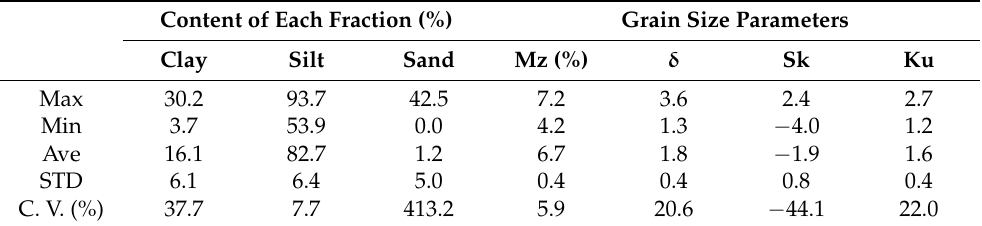
Figure 5. Grainsize classification. The mean grain size (Mz) of samples varies from 4.2 to 7.2 Φ , with an average value of 6.7 Φ . Among them, the Mz of sediments at the depth of 0 m~ − 17.8 m change little (ranging from 6.1 Φ ~7.2 Φ ). The sediment sorting coefficient varies from 1.3 to 3.6 with an average value of 1.8. The sorting coefficient ( δ ) of sediments at the depth of − 3.5 m to − 17.2 m varies slightly. The skewness (Sk) varies from − 4.0 to 2.4 with an average value of − 1.9. The kurtosis (Ku) varies from 1.2 to 2.7, with an average value of 1.6 (see details in Table 2 and Figure 6). Table 2. Statistical table of grain size parameters and fraction content of sediments of Core WH-05 (n =